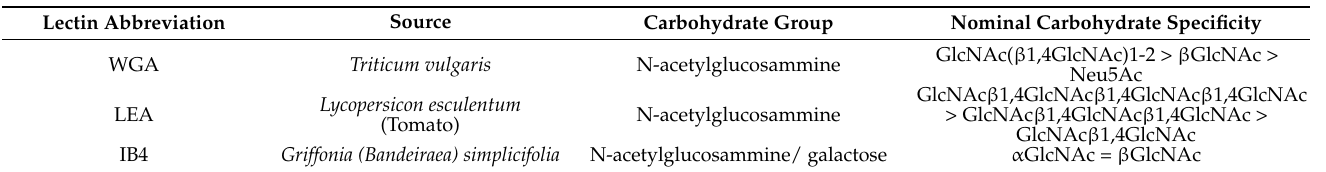
Table 1. Table summarizing the characteristics of the lectins used in the study; modified from the study by Jilani et al., 2003 [30]; nominal carbohydrate specificity as in the study by Goldstein and Poretz, 2012 [54]. Lectin